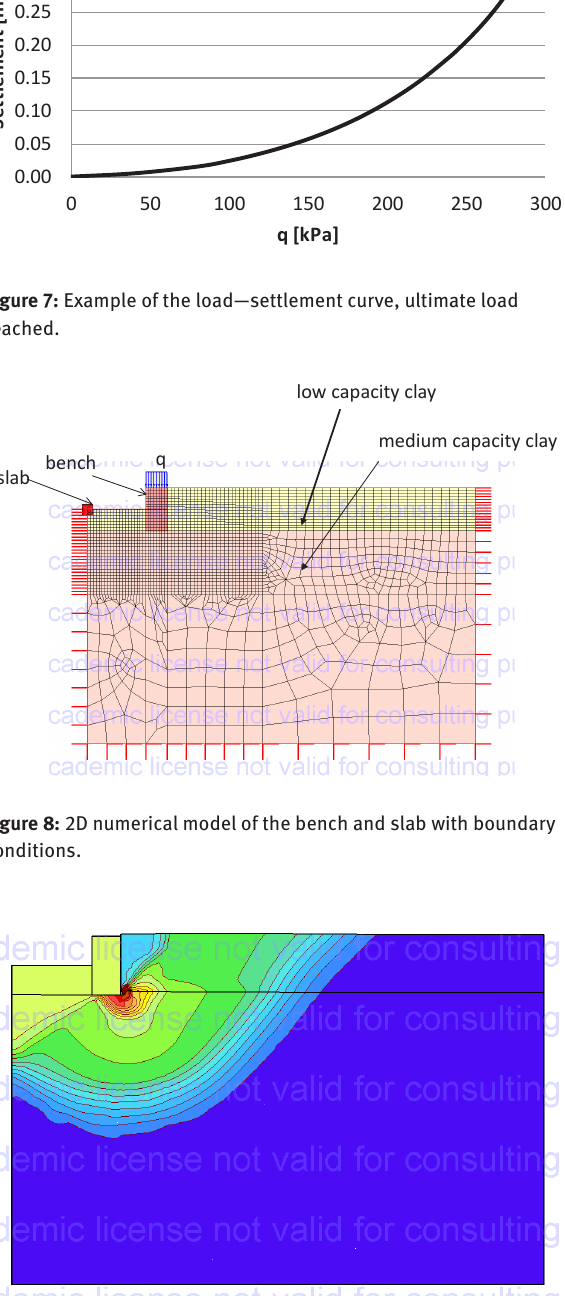
Figure 9: Failure mode of the bench and slab foundation, 2D calculations result.